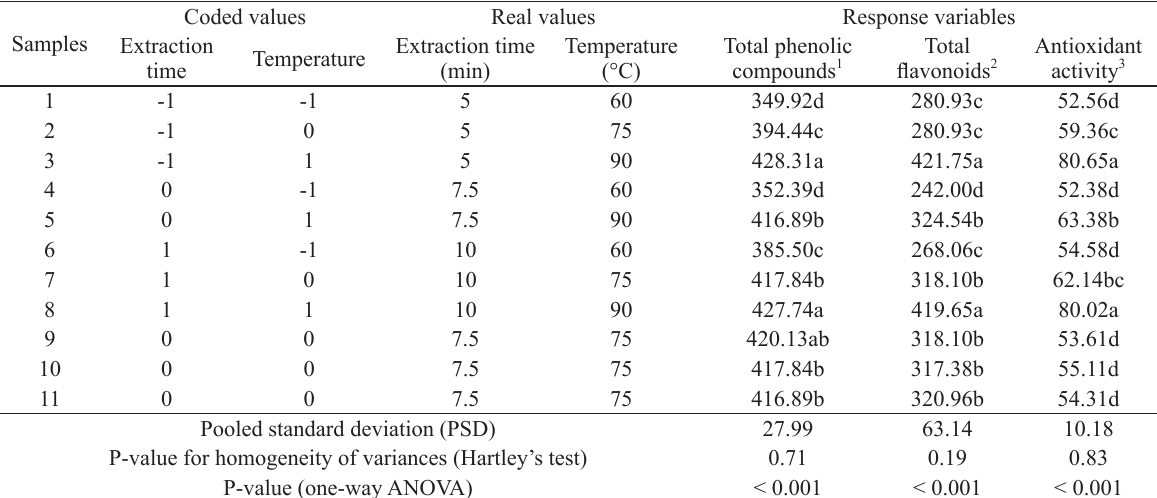
Coded and real values of temperature and extraction time of roasted yerba-mate leaves and results from the chemical and antioxidant